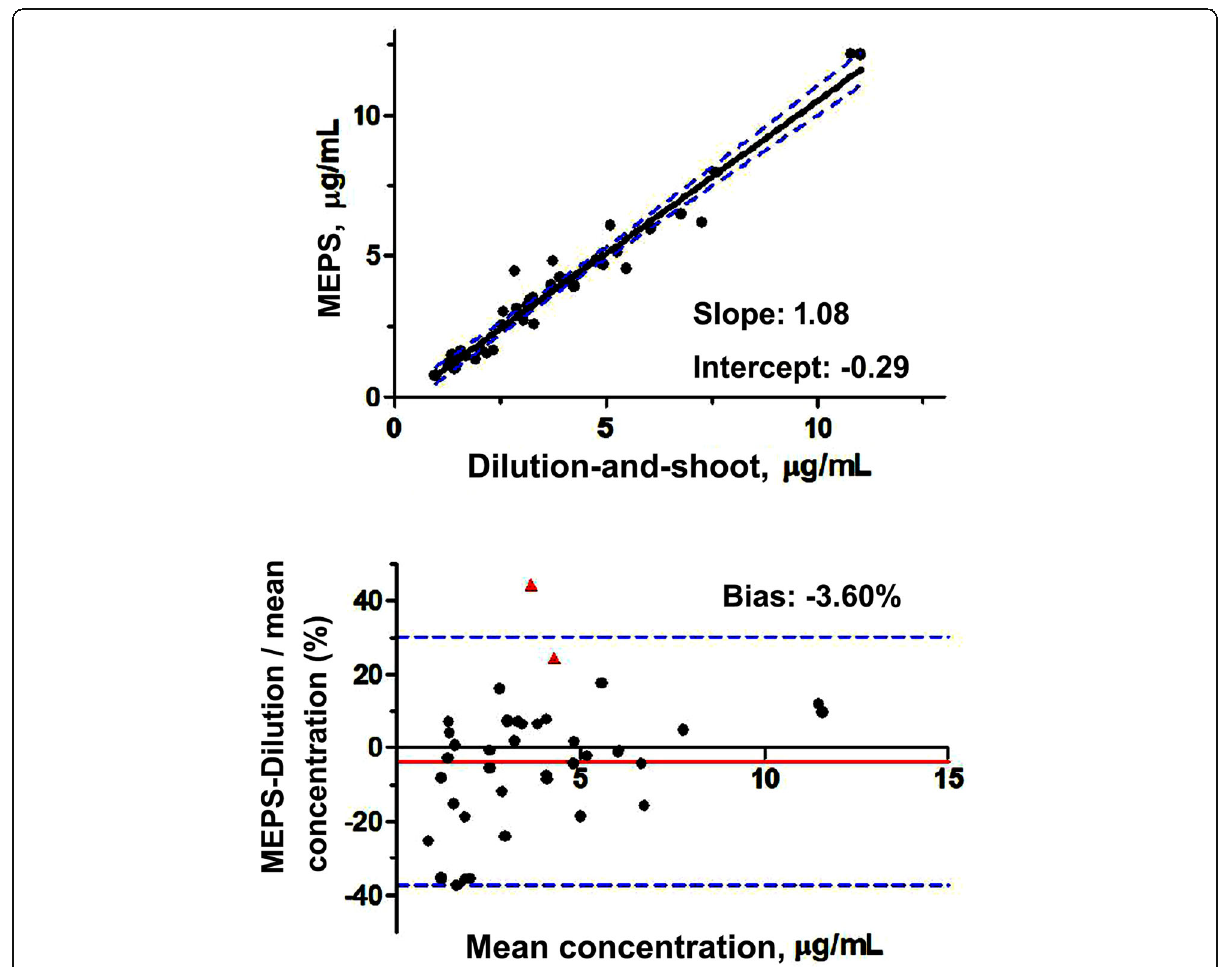
Fig. 4 Comparison between the MEPS-LC-MS/MS and dilute-and-shoot LC-MS/MS assays. Upper plots: weighed Deming fits (solid black lines); lower plots: Bland-Altman analyses (solid black lines). The dotted red lines represent the 95% limit of